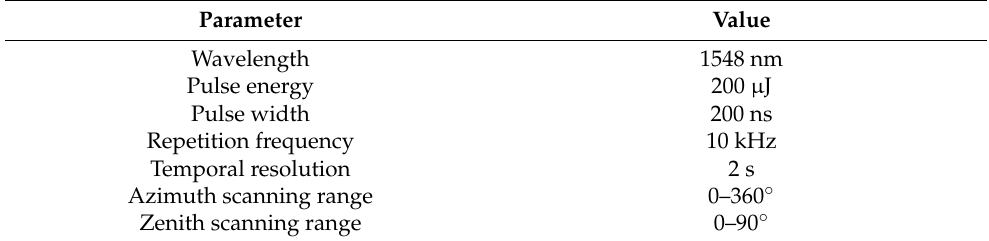
Table 1. Key Parameters of